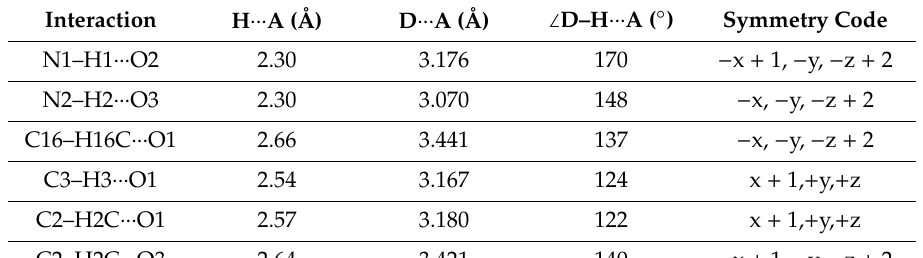
Figure 2. ORTEP representation (with 50% displacement ellipsoids) of the title compound ( 3g ) showing the atom numbering scheme. Table 3. List of intermolecular interactions in the crystal structure of 2-(3,4-dimethoxyphenyl)-2,3- dihydroquinazolin-4(1 H )-one ( 3g ) .